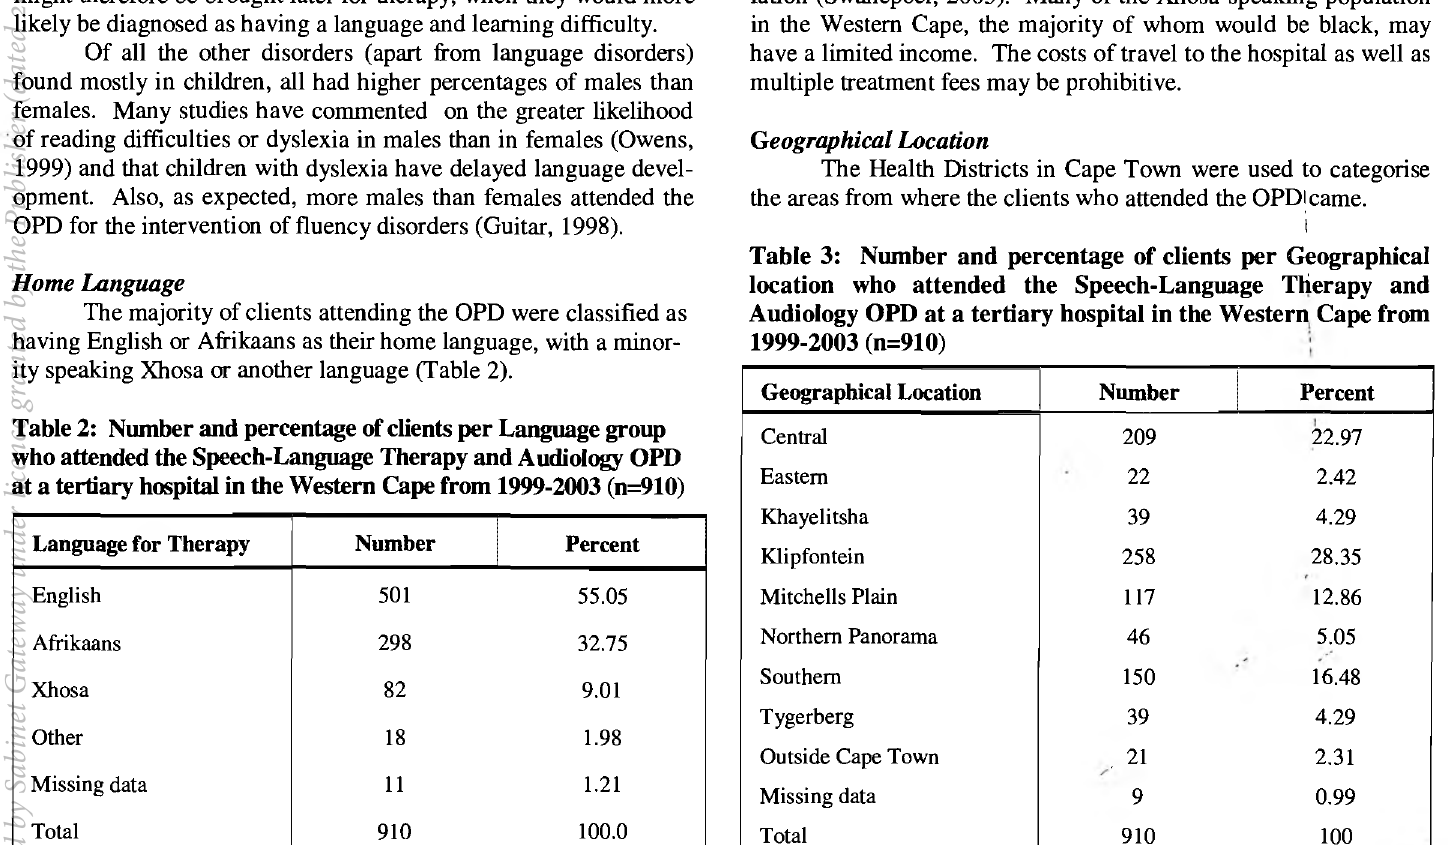
Table 3: Number and percentage of clients per Geographical location who attended the Speech-Language Therapy and Audiology OPD at a tertiary hospital in the Western Cape